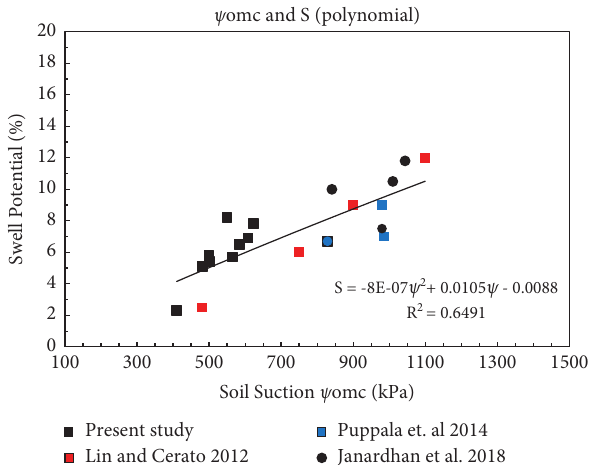
Figure 14: Demonstration of the newly developed polynomial correlation for the swell potential of swelling soils.